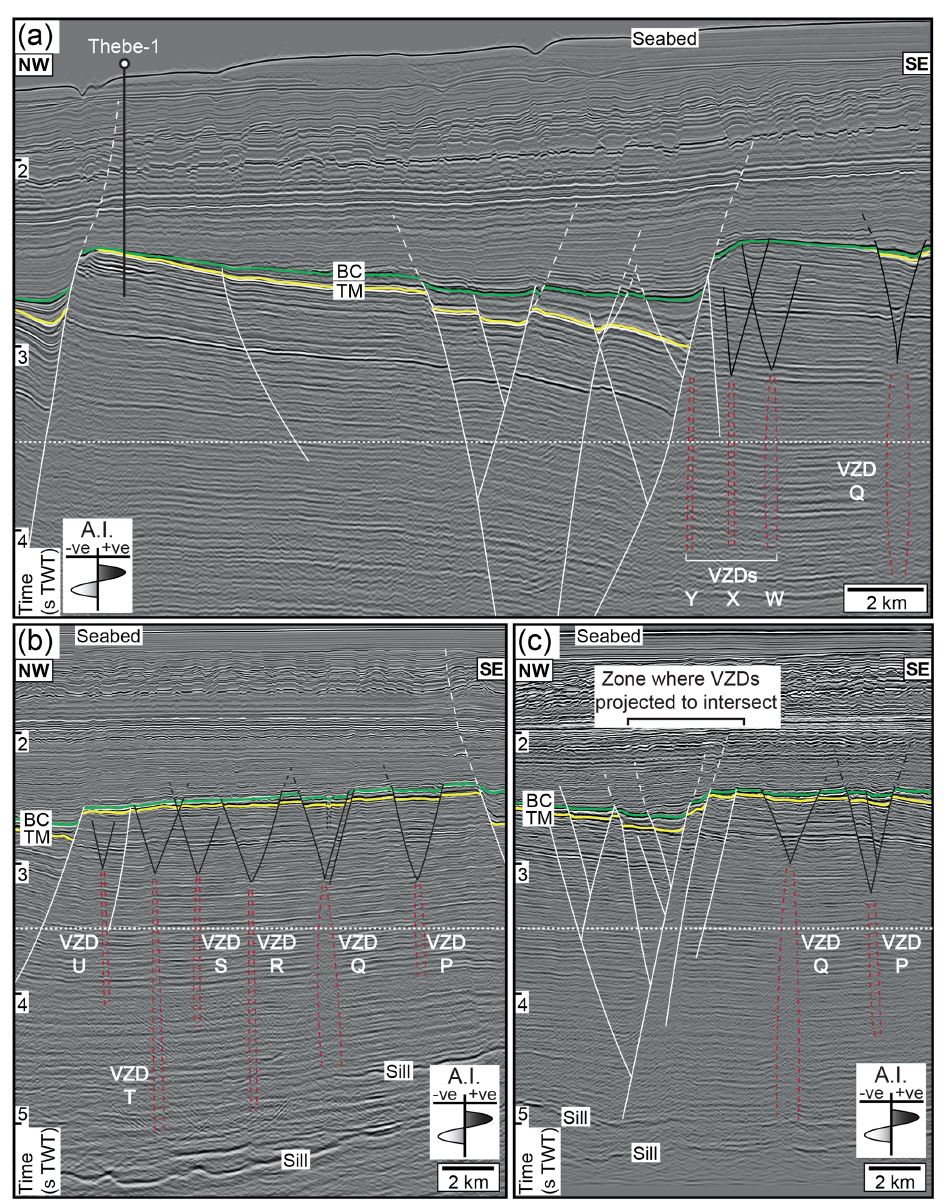
Figure 7. (a–c) Interpreted seismic sections from different surveys demonstrating the variations in VZD expression. See Fig. 4d for line locations and Fig. 6 for key. See Fig. S6 for uninterpreted